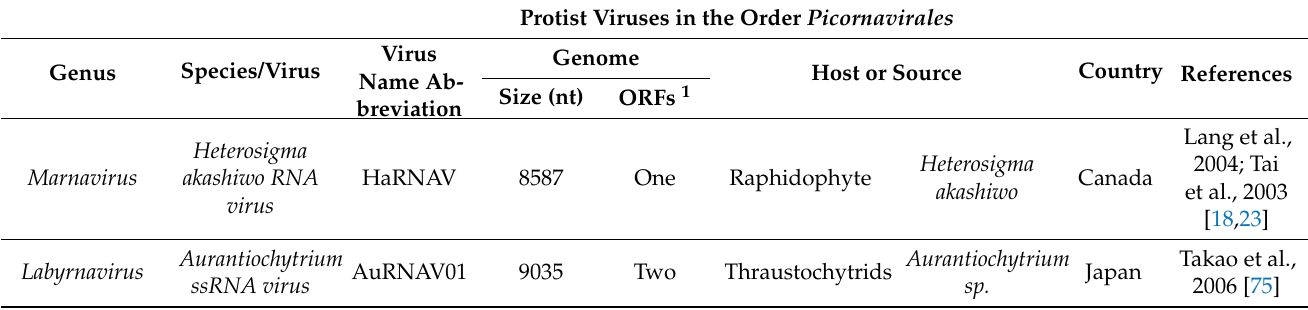
Figure 1. Maximum-likelihood phylogenetic analysis of the RdRp domain RNA sequences of the 22 aquatic RNA virus sequences belonging to the family Marnaviridae . The phylogenetic tree was constructed by the maximum likelihood (ML) method using MEGA 7.0 software. Illustration by authors. Table 1. RNA viruses discussed in this review in the order Picornavirales